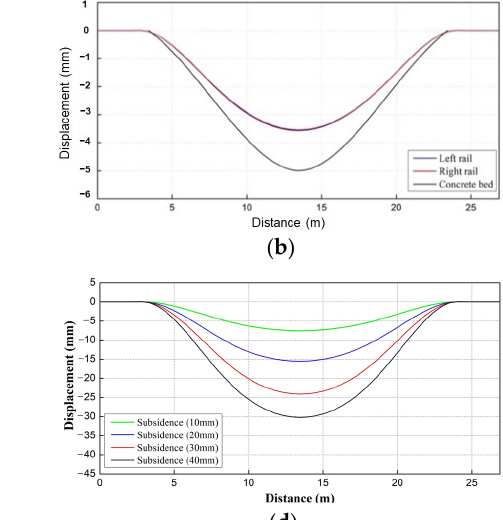
Figure 7. FE analysis results (displacement, z direction) for: ( a ) rails and concrete bed under 5 mm uplift; ( b ) rails and concrete bed under 5 mm subsidence; ( c ) rails under 10–40 mm uplift; and ( d ) rails under 10–40 mm